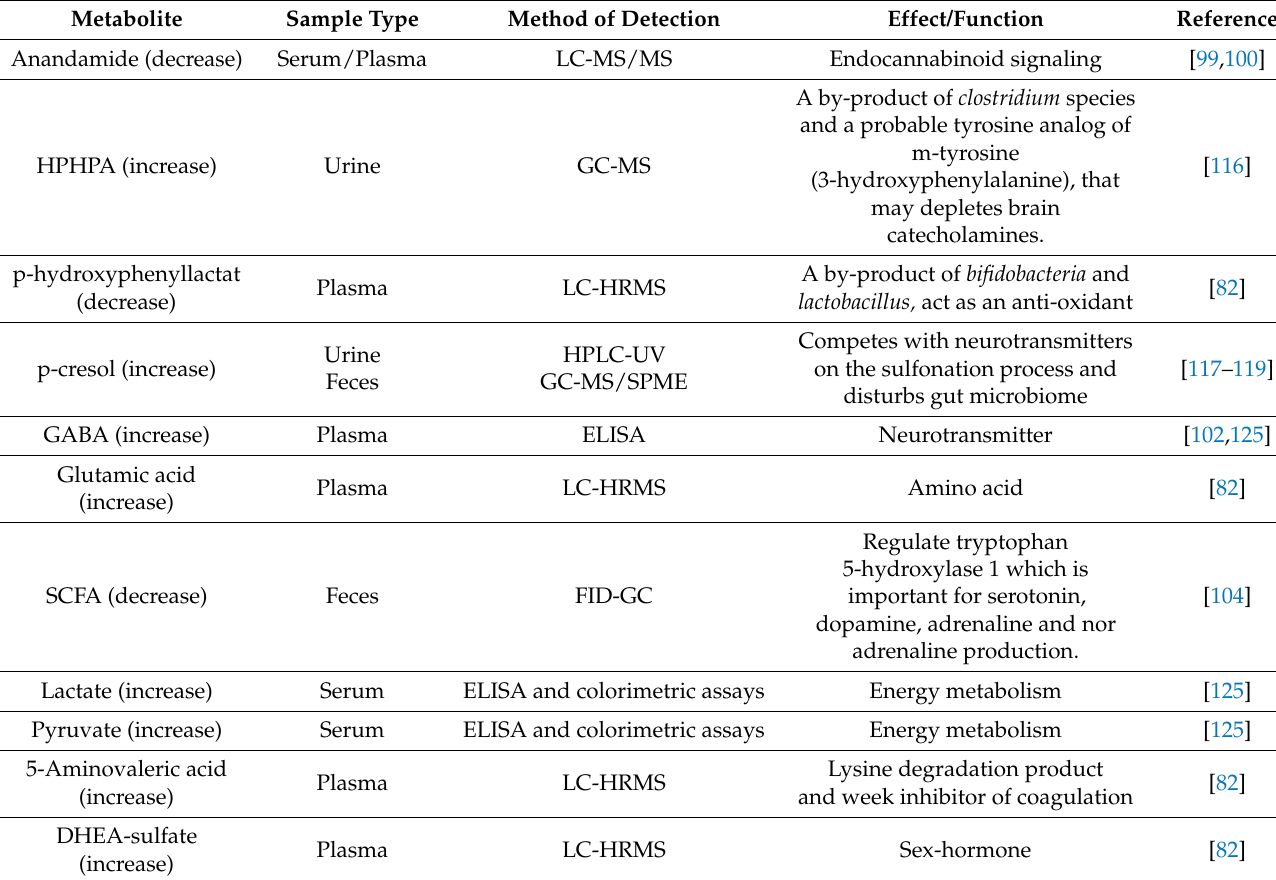
Table 4. Metabolomic biomarkers in